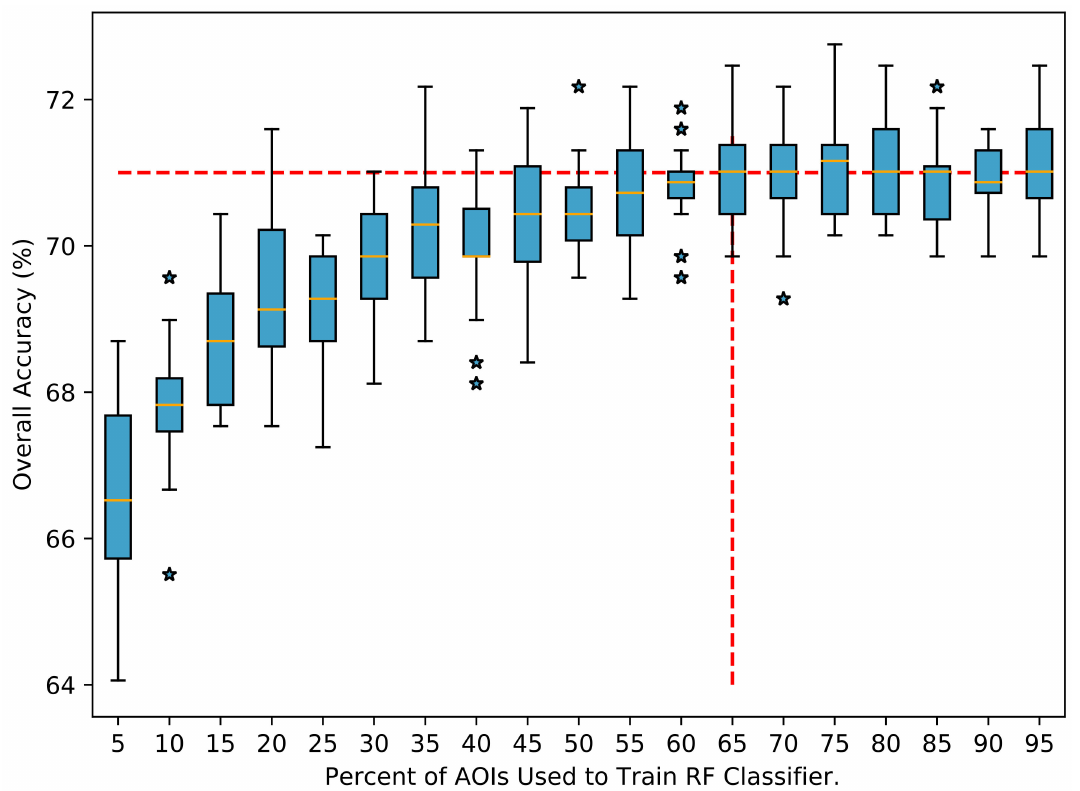
Figure 15. Overall accuracy assessment of classification results after integrating AOIs layers. The two black whiskers extend from the first quartile to the smallest value and from the third quartile to the largest value. The median is shown with an orange line. Extreme values are indicated with symbol of (cid:73) . The horizontal red dashed line shows the value at which the overall accuracy has stabilized, and the vertical red dashed line represents the first experiment in which the overall accuracy is